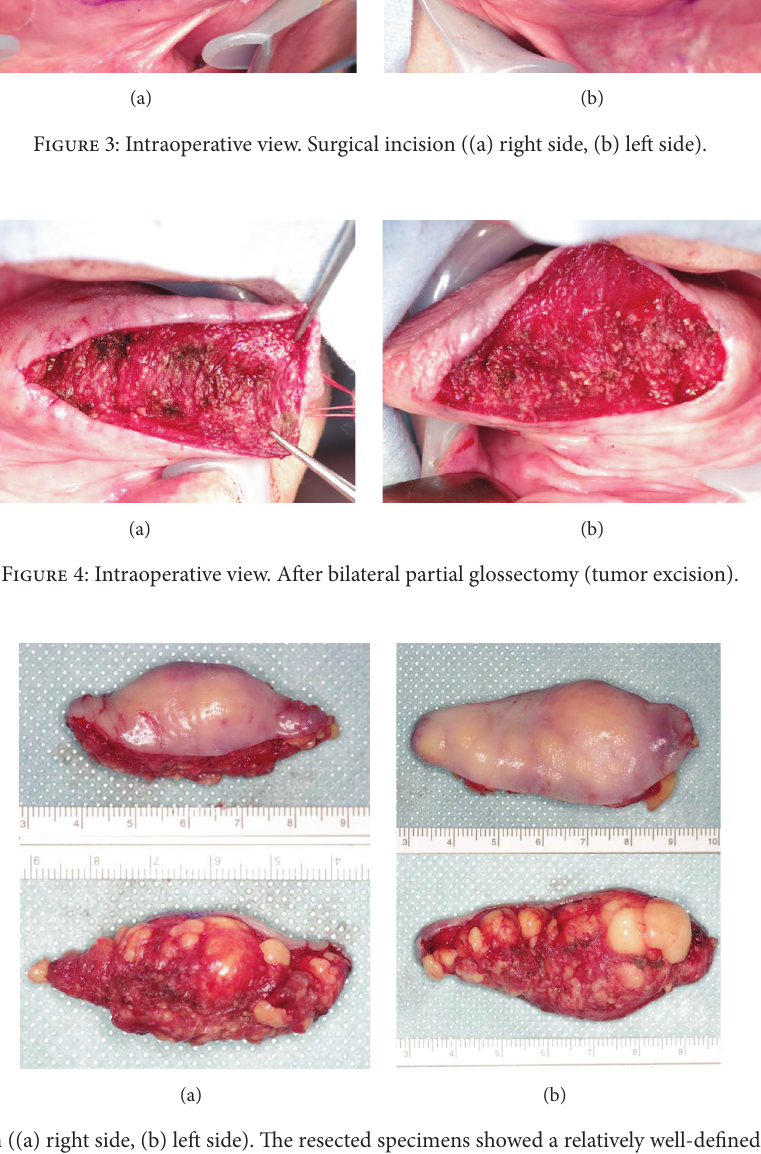
Figure 5: Surgical specimen ((a) right side, (b) left side). The resected specimens showed a relatively well-defined border in the mucosa but the encapsulation was not clear in the deep